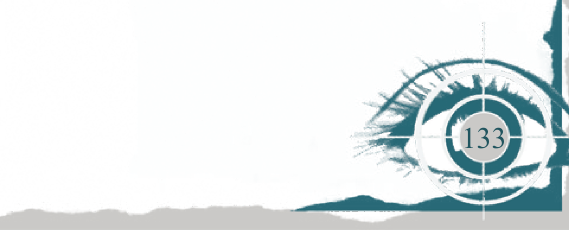
The South African